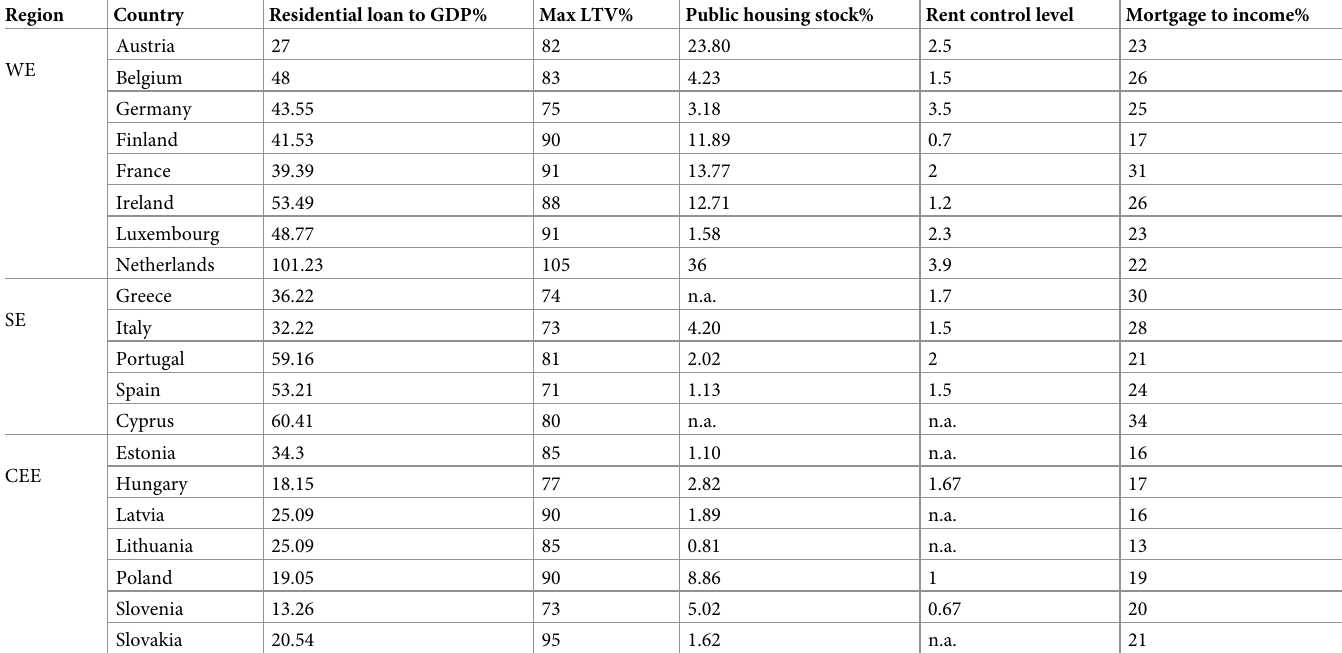
Table 2. Descriptive statistics of macro-level indicators, by